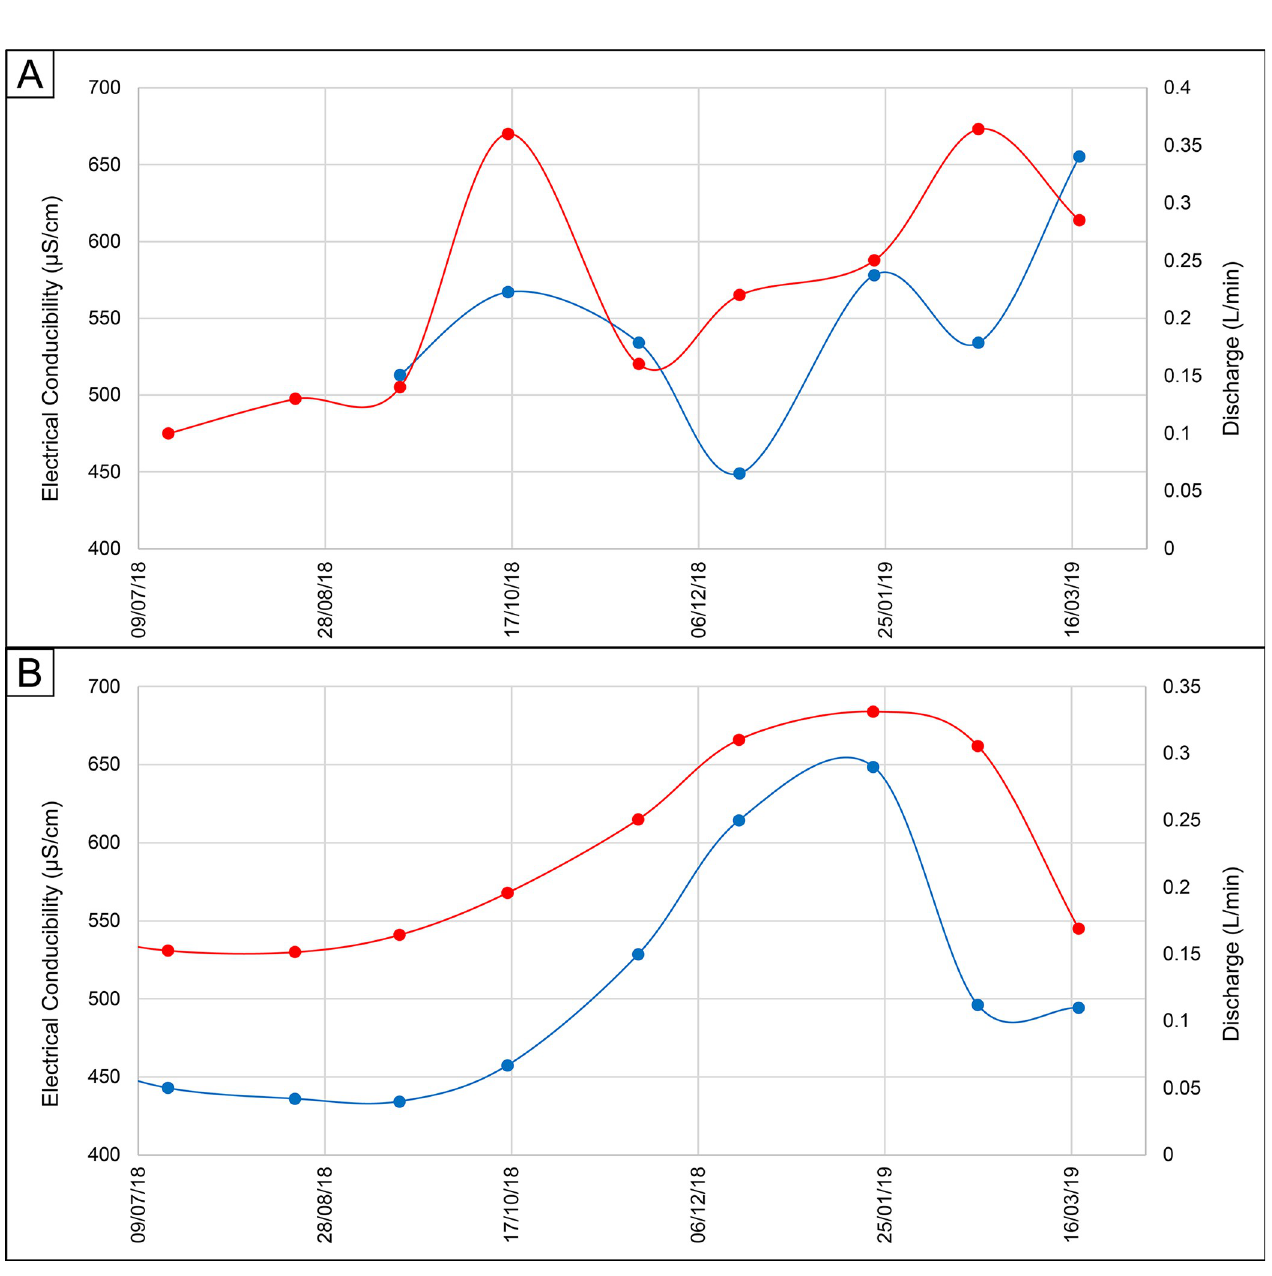
Fig 9. Examples of EC fluctuations (red line) vs. discharge (blue line). Graph A) represents spring P008 and graph B) in spring 153. Dates are given in